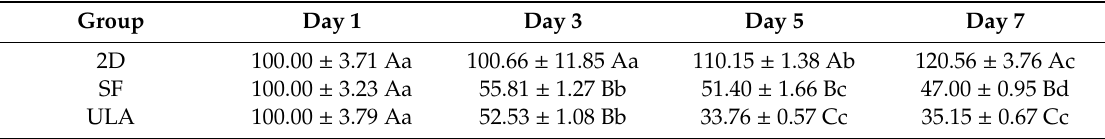
Table 1. Cell viability test by the cell counting kit-8 (CCK-8).